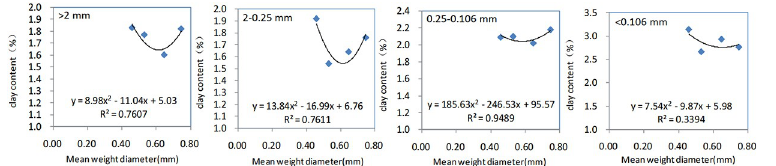
Fig 2. Regression analysis of clay concentrations and MWD values of soil aggregates for different amounts of